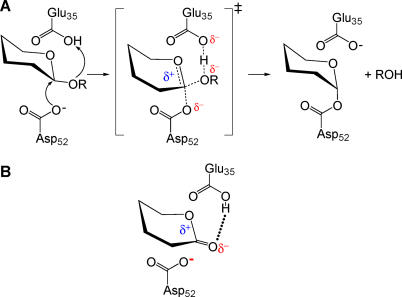
Geometric or Electrostatic Complementarity in the Lysozyme Reaction(A) Simplified mechanism of lysozyme. Asp52 attacks the substrate, and the general acid Glu35 protonates the leaving group oxygen. The reaction proceeds through a loose transition state, in which the bond to the leaving group is nearly broken with only a small amount of bond formation to the incoming aspartate. Instead, positive charge accumulates on the C1 carbon of the sugar and the ring oxygen atom (δ
+). This transition state has a half-chair or sofa-like conformation, distinct from the ground state chair conformation [
31,
36].
(B) Simplified structure of a transition-state analog that binds tightly to lysozyme [
32]. This analog has the same half-chair conformation as the transition state. It also has a similar charge distribution, with positive charge localized on the carbon and oxygen atoms in the ring and negative charge on the carbonyl oxygen.